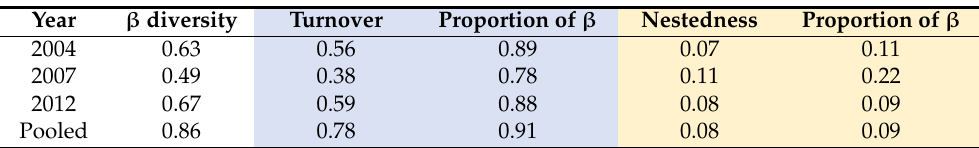
Table 3. β diversity and contribution of its components for GoM exposed headland rocky intertidal species assemblages for each survey year and all years pooled.